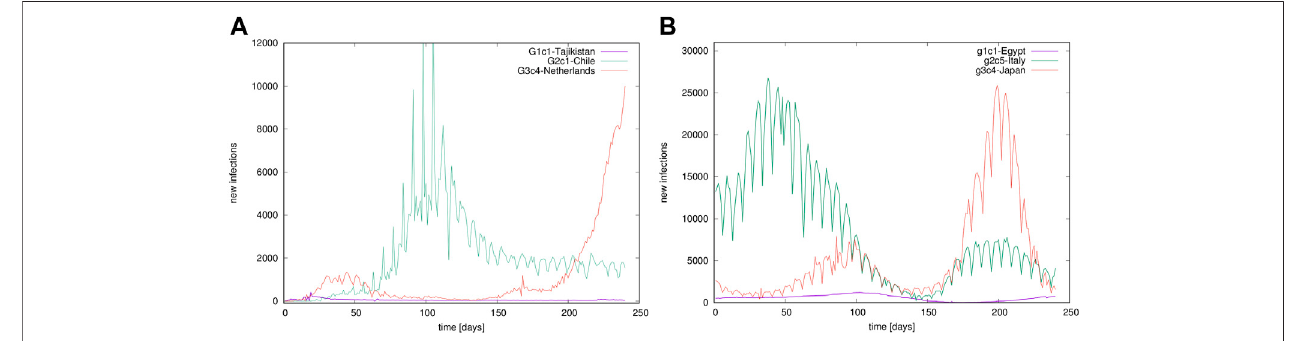
FIGURE 1 | Examples of time series. Temporal evolution of con fi rmed infection cases in different countries, belonging to different groups in the outbreak (A) and immunisation phase (B)